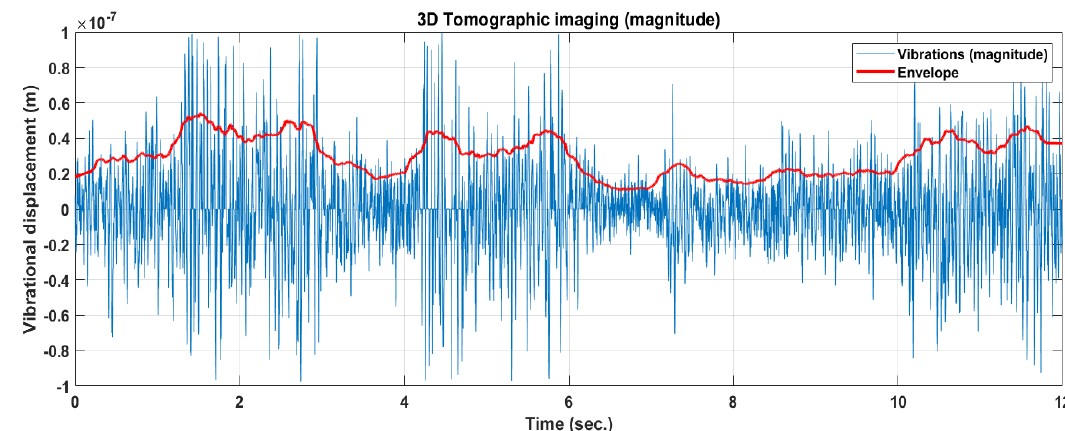
Figure 4. Time domain vibrations (magnitude).